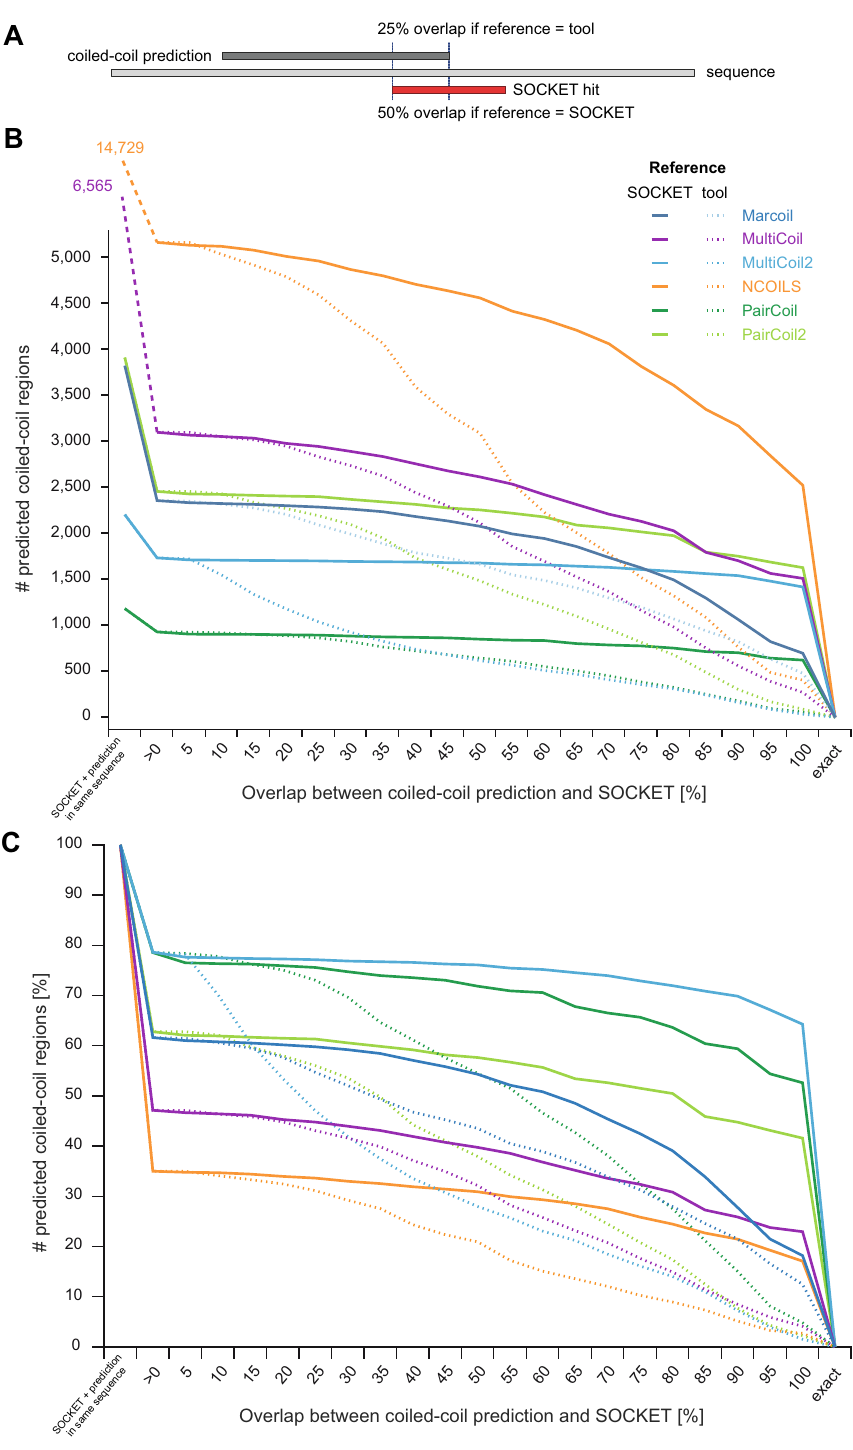
Figure 4. Overlap of coiled-coil predictions with SOCKET hit regions. ( A ) Schematic drawing of a coiled-coil prediction overlapping a SOCKET hit. The ratio of overlap between prediction and SOCKET hit is different depending on whether the prediction or the SOCKET hit is taken as reference. ( B ) The plot shows the total number of coiled-coil predictions in dependence of the degree of overlap with the SOCKET hits. The values at the left side indicate the number of PDB sequences containing both a SOCKET hit and a coiled-coil prediction. For each tool, the number of overlapping hits is counted once with taking the coiled-coil prediction as reference (solid lines) and once with the SOCKET hits as reference (dashed lines). ( C ) This plot is similar to ( B ) but shows the percentage of overlapping regions with respect to the overlap ratio. The number of sequences containing both a coiled-coil prediction and a SOCKET hit is set to 100% for each tool. A similar plot with the number of predictions overlapping a SOCKET hit with at least a single amino acid set to 100% is shown in Supplementary Fig.